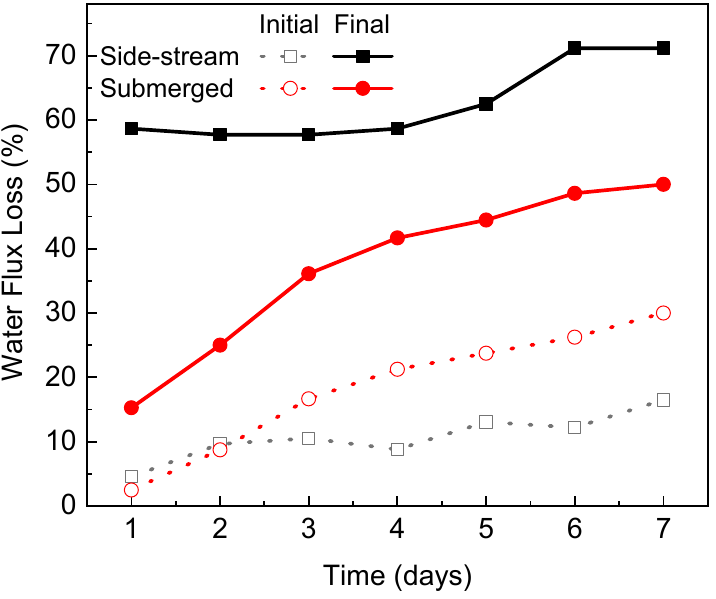
Figure 7. Normalized flux loss at the start and end of each algae dewatering experiment.